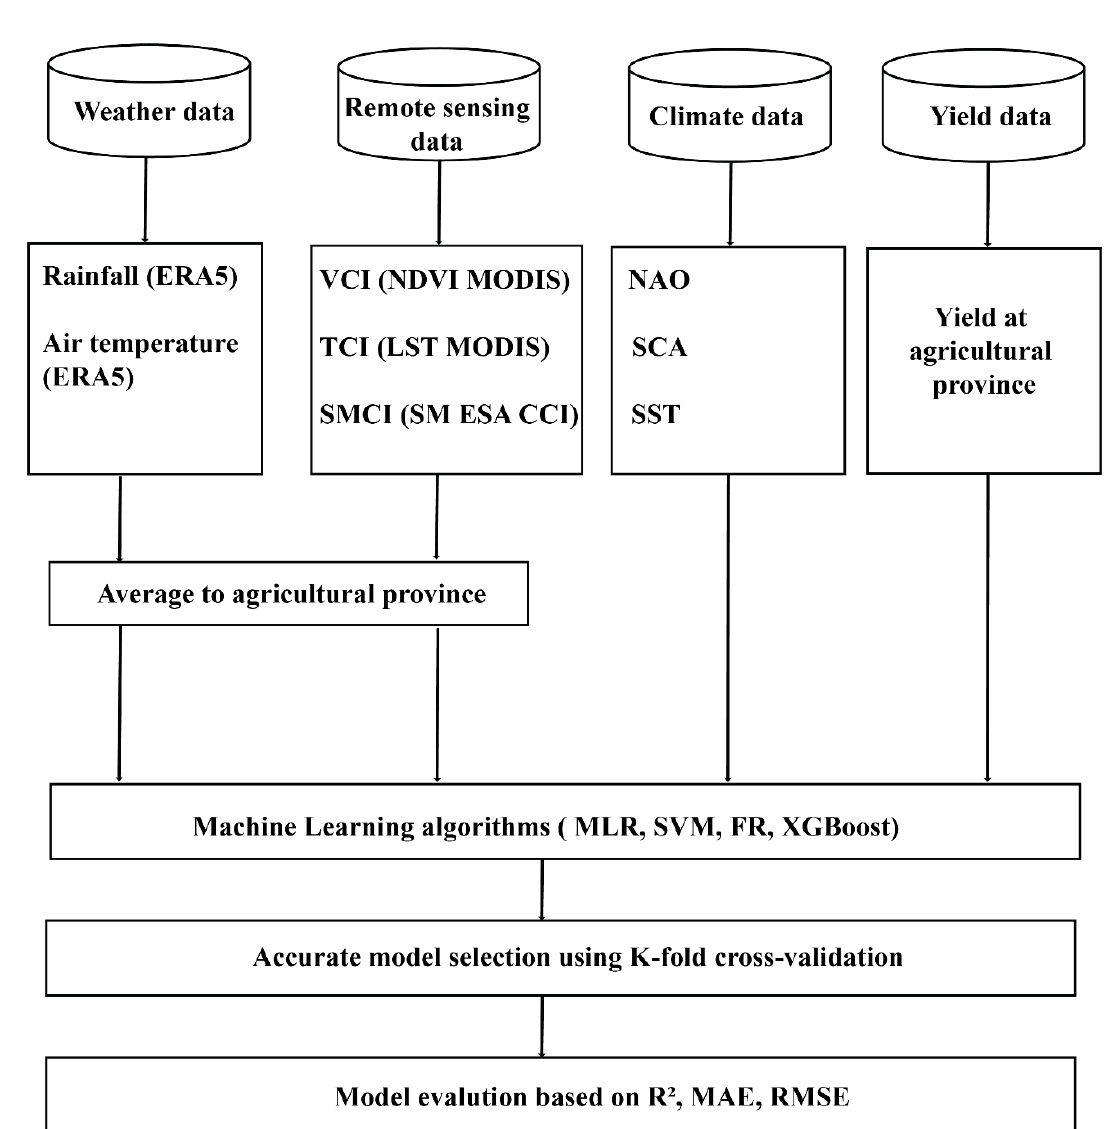
Figure 2. Schematic diagram presenting an overview of the main inputs data and the methodology proposed in this study.